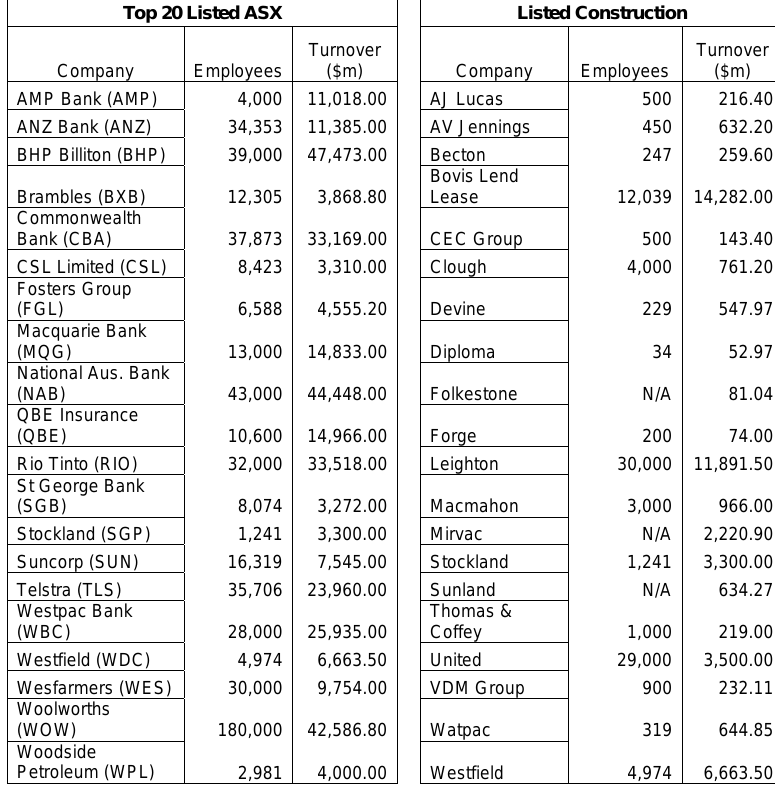
Table 2: Sample structure: ASX listed non-construction and construction companies